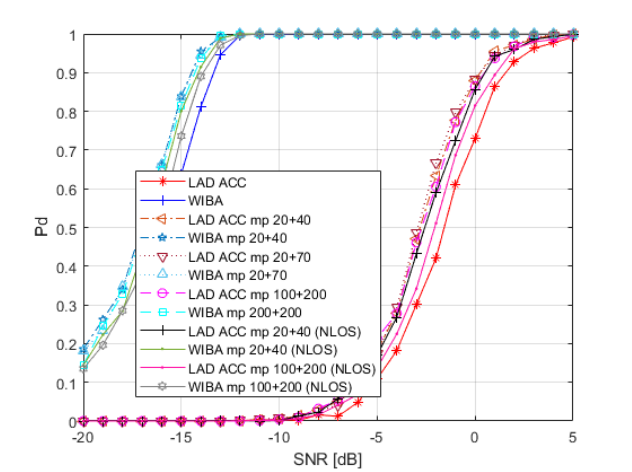
Figure 9. Probability of detection vs. SNR in multipath channel case. Signal bandwidth is 10% and M = 102 . AWGN, Rician (LOS) and Rayleigh (NLOS) channels.